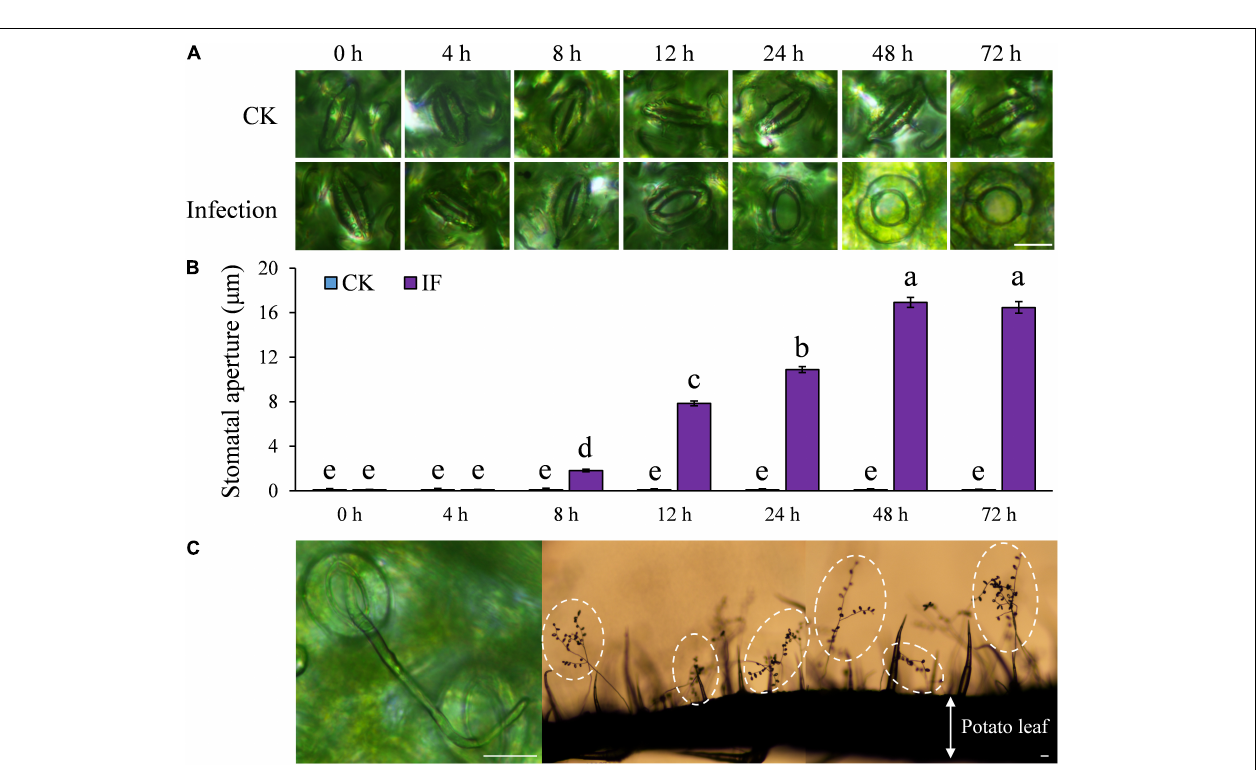
FIGURE 2 | Images showing that potato defenses against P hytophthora infestans infection at the interface of stomata: (A) hypersensitive-like cell death occurred specifically in guard cells 8 h post infection; and (B) permanent closure of stomata during the whole infection course after the death of guard cells. The marker = 50 µ m. Photos within a panel are from a representative of a single replicate while photos among panels are pooled from multiple replicates.